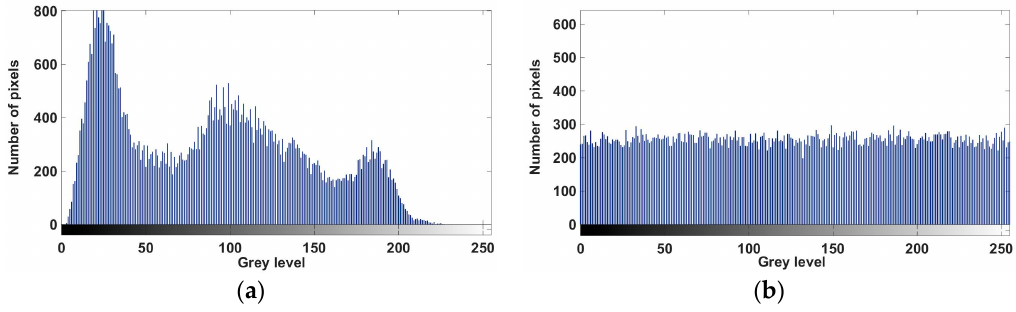
Figure 11. ( a ) Histogram of the test image; ( b ) histogram of the encrypted image.